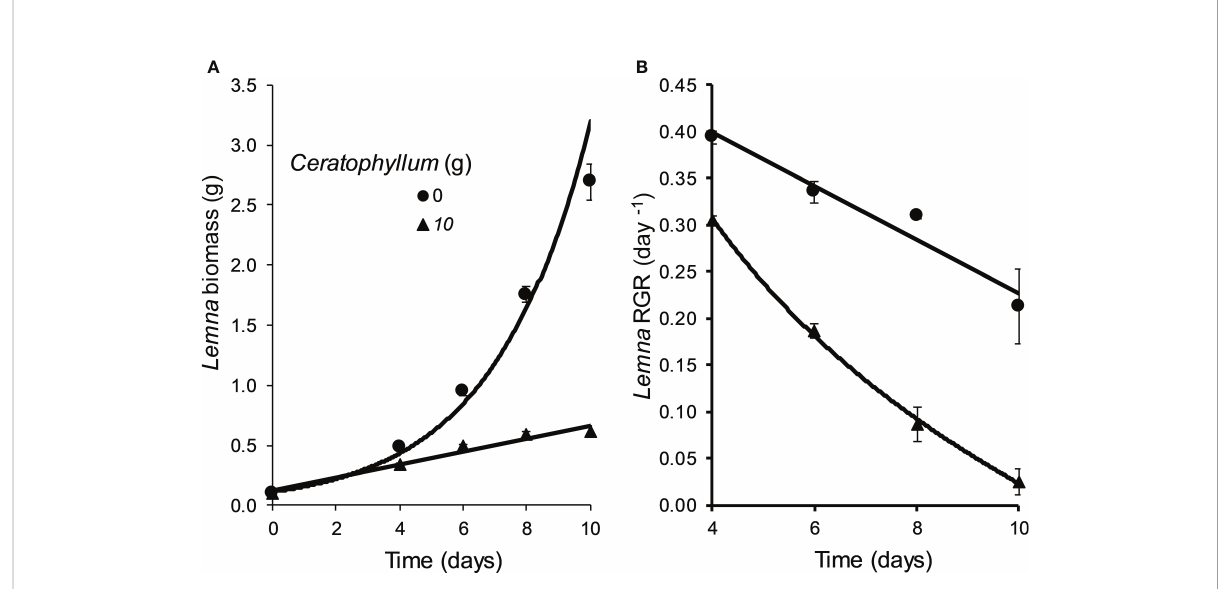
FIGURE 2 Effect of Ceratophyllum demersum on the biomass (fresh weight) (A) and the relative growth rate (RGR) (B) of Lemna gibba compared to treatments without C. demersum (means ± standard error, n =